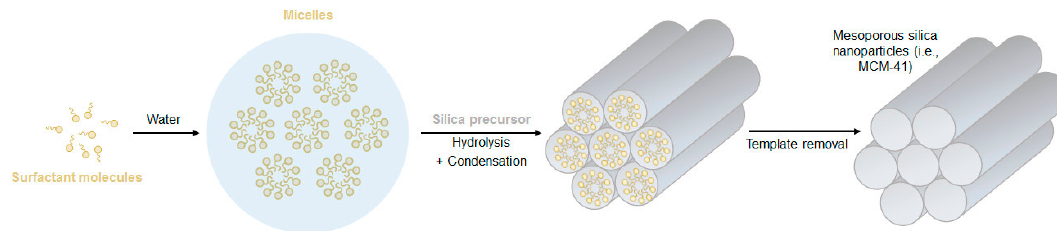
Figure 8. Schematic illustration of the formation mechanism of mesoporous silica nanoparticles